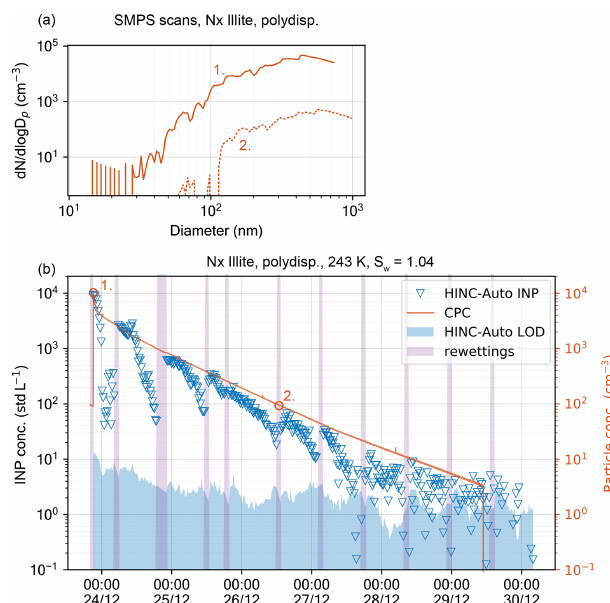
Figure 11. INP concentration in HINC-Auto as a function of time and NX illite particle concentration. (a) SMPS retrieved particle size distribution at times 1 (solid line) and 2 (dashed line). The DMA sheath flow was set to 5 (solid line) and 2Lmin − 1 (dashed line). (b) Measured INP and particle concentrations within the aerosol